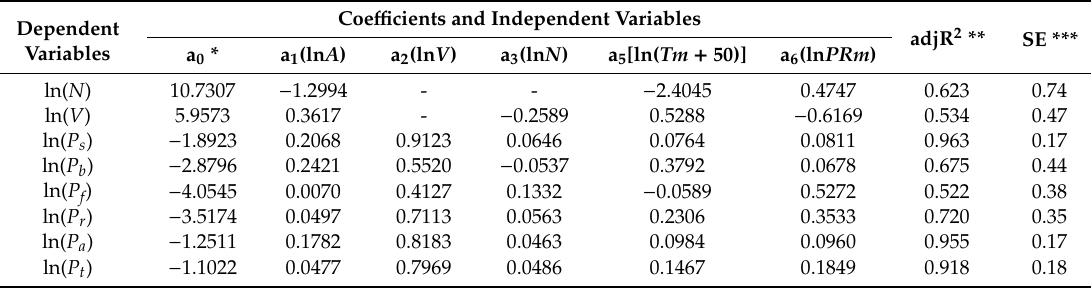
Table 3. Characteristics of biomass Equations (1) to